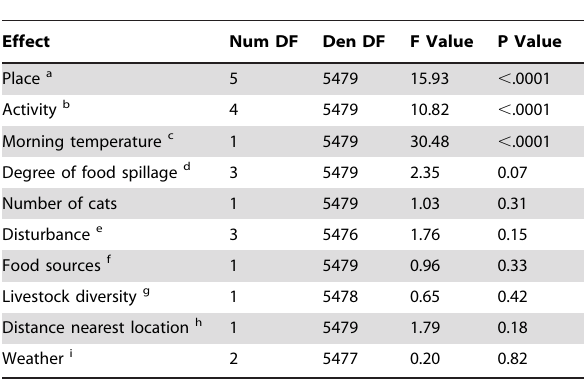
Table 2. Generalized linear mixed model (GLIMMIX module in SAS 9.1; exponential error function; Type III Tests of Fixed Effects) showing the effect of independent model terms on House sparrow group sizes (n= 6067 groups) in 36 locations.